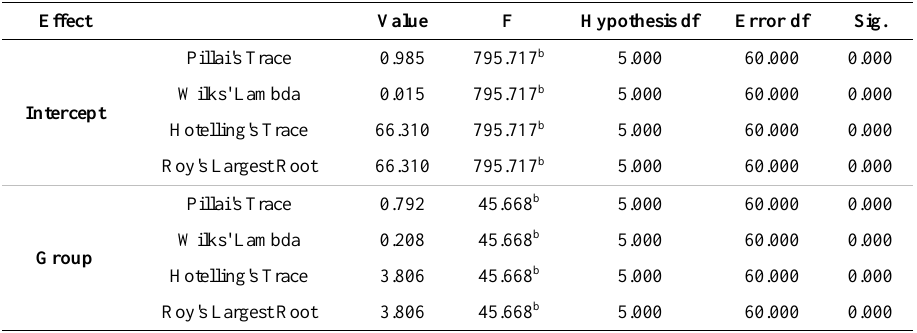
Table 3. Mean values from multivariate tests